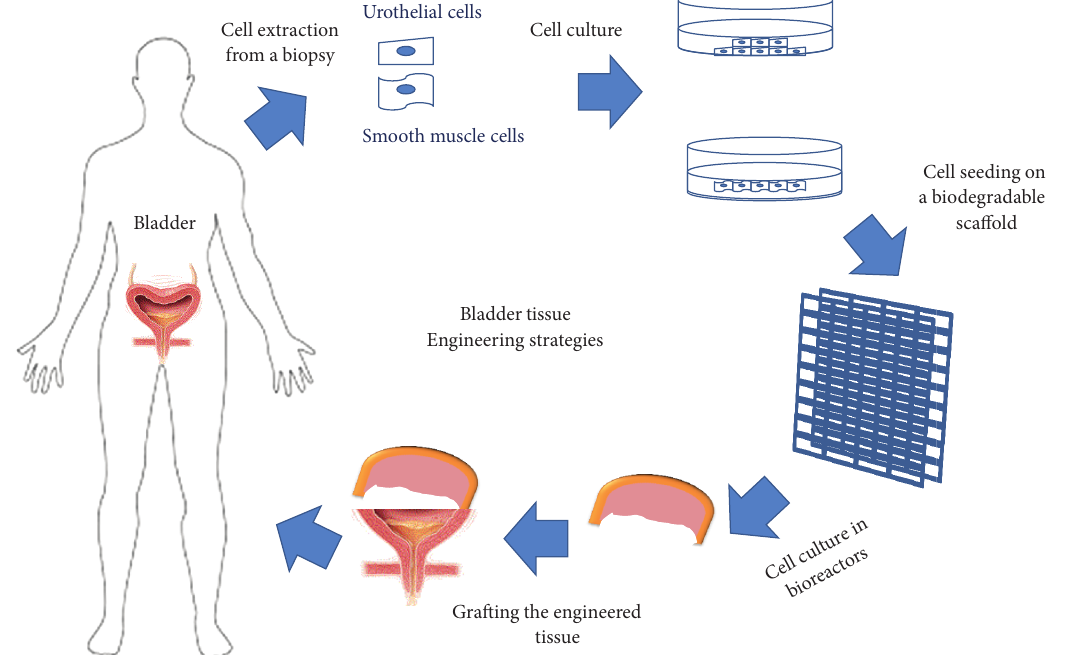
Figure 5: General strategy for tissue-engineered urinary